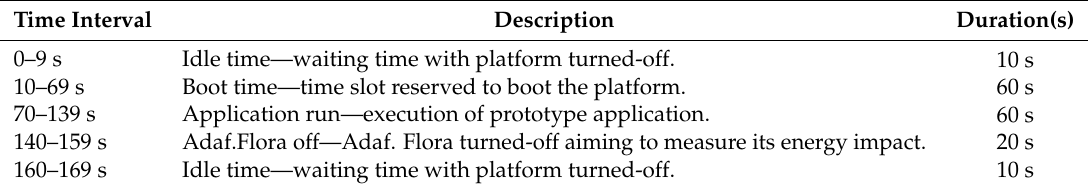
Table 5. Test protocol used to measure energy consumption on wearable